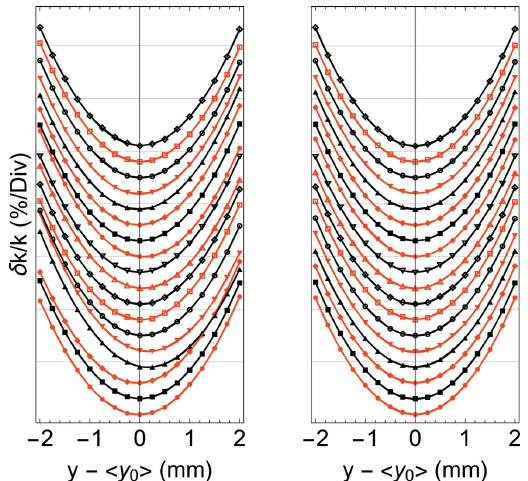
Figure 5 (Left) Relative variation of the local K , k n , for each pole, as a function of the vertical position before correction. (Right) The same quantity after corrections. On the vertical scale an offset is added between each pole to better distinguish their individual